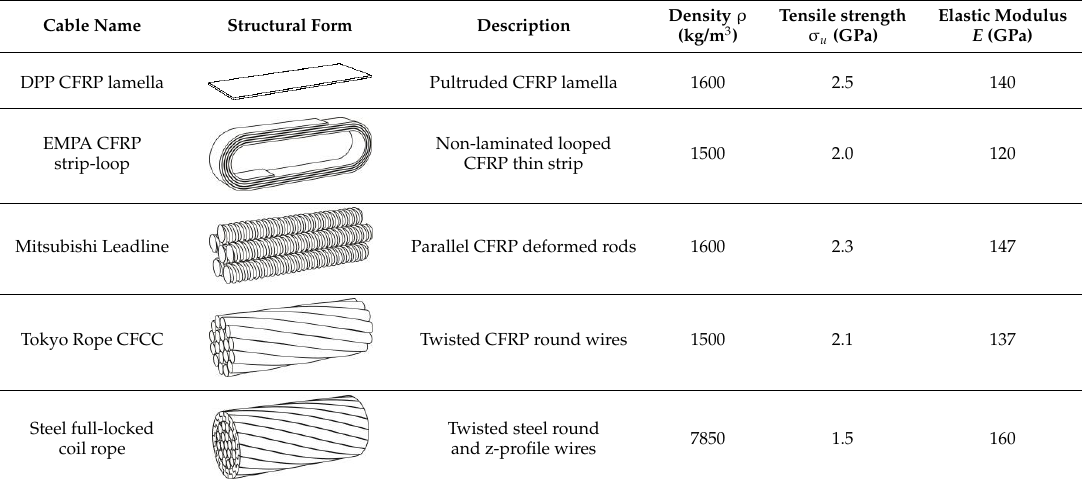
Table 3. Mechanical properties of CFRP cables compared with steel cable.